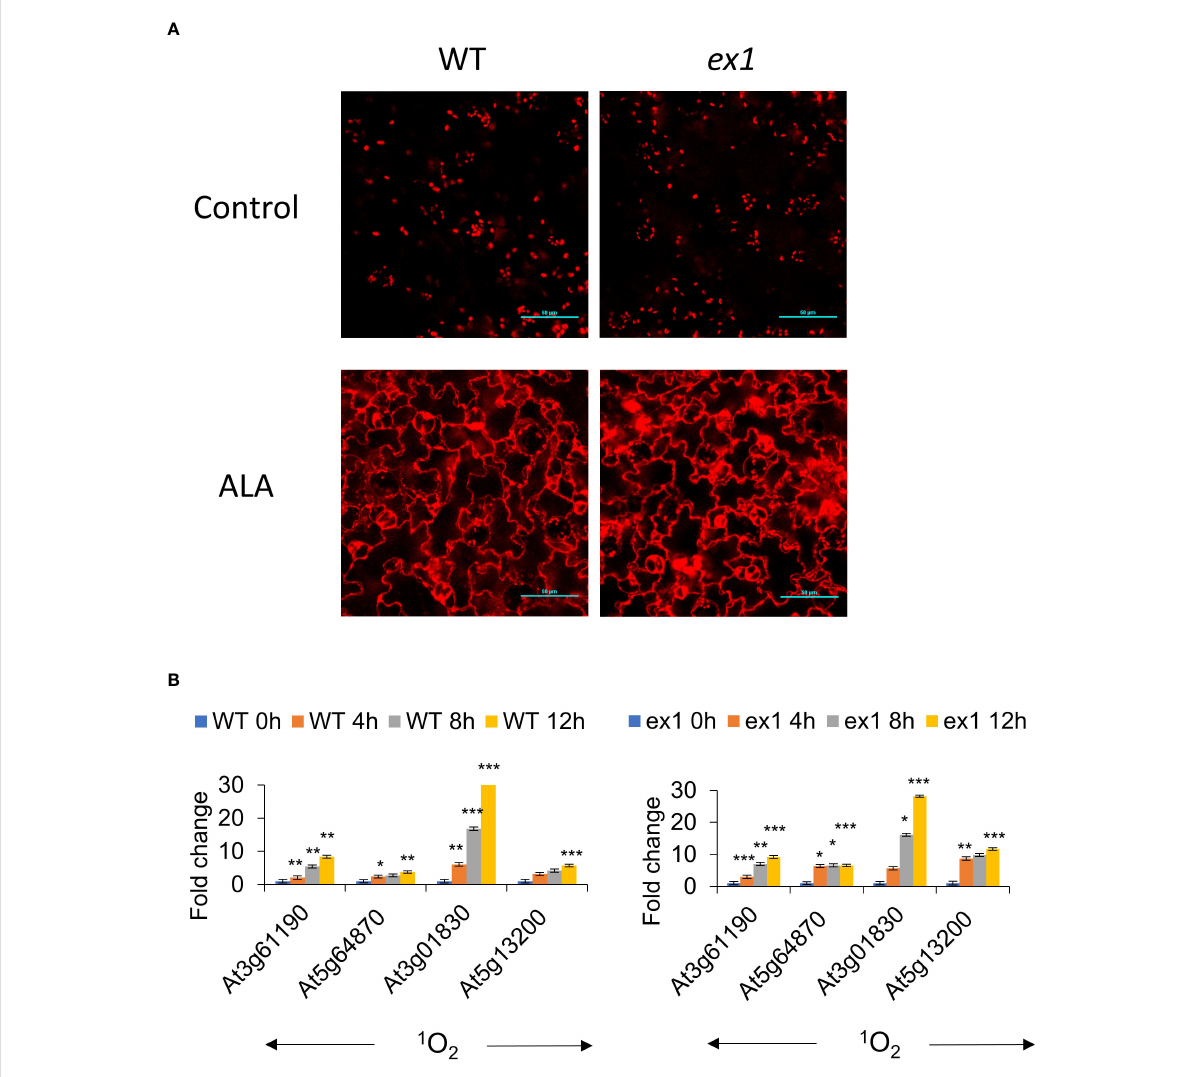
FIGURE 5 Extrachloroplastic accumulation of chlorophyll is not regulated by the executor pathway under ALA treatment. (A) Accumulation of chlorophyll in extrachloroplastic regions under ALA treatment. Arabidopsis WT and ex1 seedlings were incubated with 1 mM ALA (in MS) in the dark for 12 h, and then mounted for visualisation by confocal microscopy. Ex/Em: 630/690 nm. Scale bar represents 50 µm. (B) Arabidopsis WT and ex1 seedlings were treated with 1 mM ALA (in MS) and incubated in the dark for 0, 4, 8, 12 h in the dark before 30 min exposure to low light (30 µE m -2 s -1 ). RNA was extracted and processed as described in the Materials and Methods for qRT-PCR analysis. The means and SE of three replicates is shown. Student ’ s t-test was performed against their respective controls for signi fi cance (* - P<0.05; ** - P<0.01; *** -